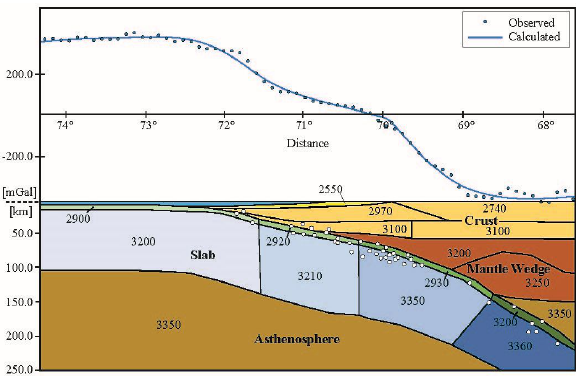
Figure 4: 2.5-dimensional (2.5-D) gravity model of the Central An- des subduction zone along 19 ◦ S. The numbers in the model are densities in kg m −3 . The white circles are earthquake hypocenters (events from 1957 -